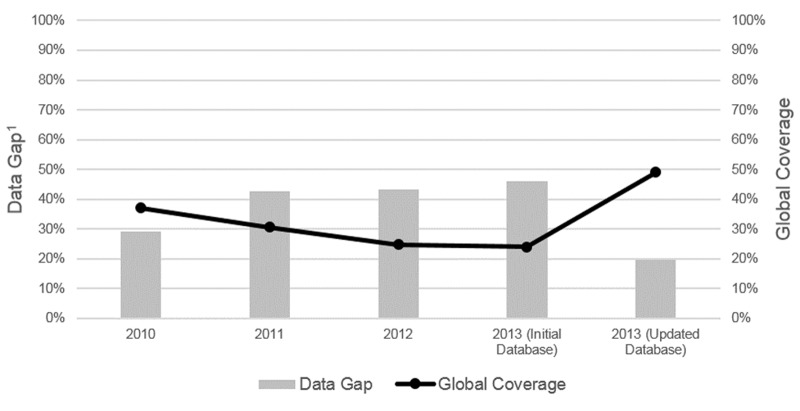
Annual pre-SAC global coverage and data gaps1, 2013.Proportion of global pre-SAC population requiring deworming and treated and the global data gap for the years (2010–2013). pre-SAC, preschool-age children. 1Data gap is proportion of pre-SAC population requiring deworming for the countries not responding. 2Initial Database, WHO Preventive Chemotherapy and Transmission Control Databank as of January 15th 2015, Updated Database 3WHO Preventive Chemotherapy and Transmission Control Databank as of April 15th 2015